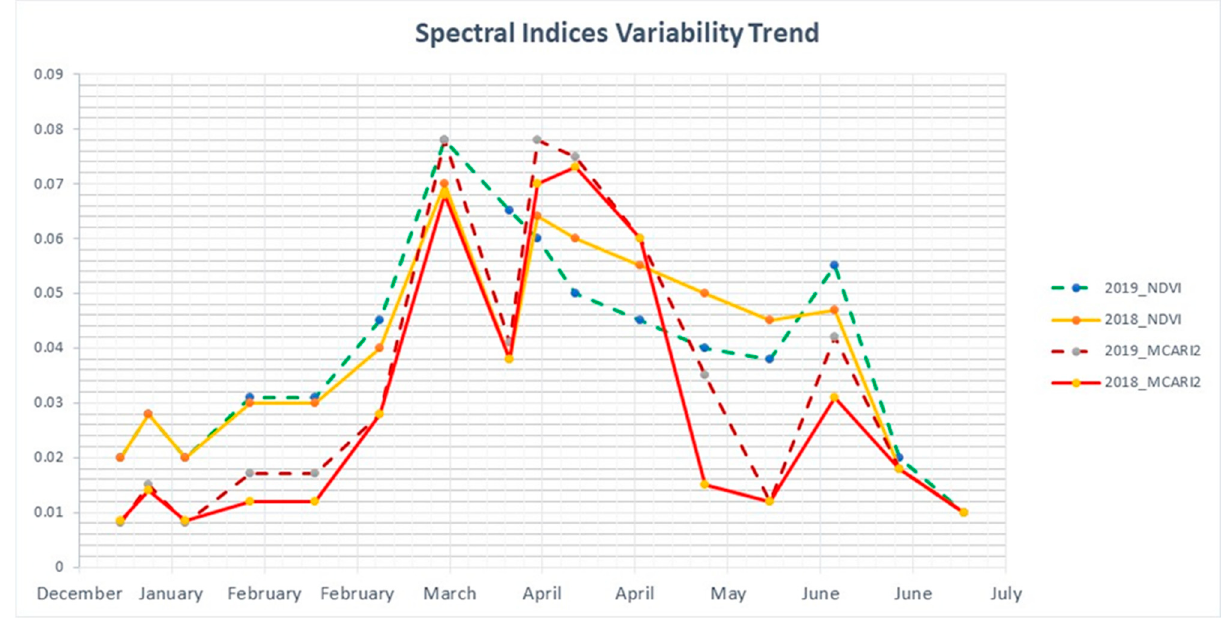
Figure 4. Standard deviation variations for average VIs collected during 2018 and 2019.